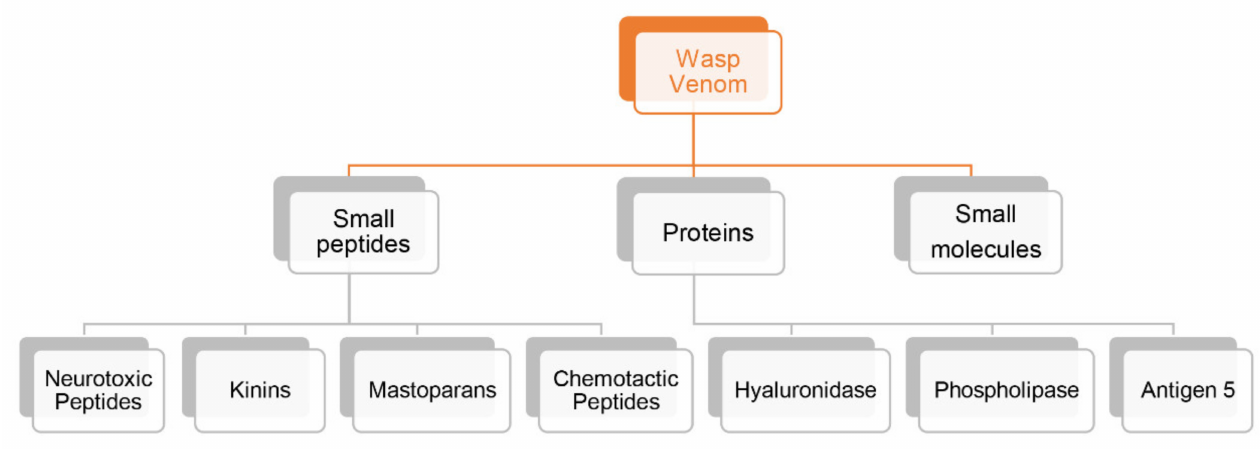
Figure 1. The basic components of wasp